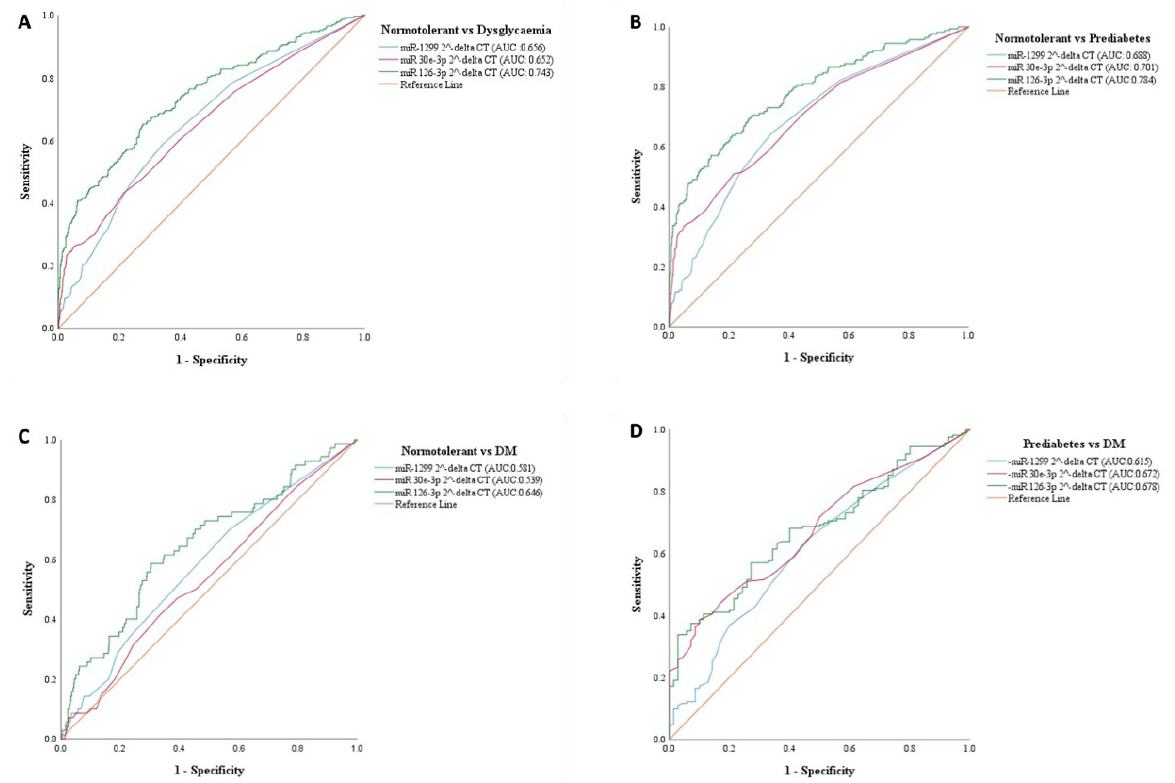
Figure 2. Receiver operating characteristic (ROC). ROCs were constructed for each miRNA to evaluate their diagnostic value for prediabetes, diabetes, dysglycaemia as positive cases and normotolerant people as negative cases, as well as for diabetes as positive cases and prediabetes as negative cases. ( A ): Dysglycaemia vs normotolerant ( B ): Prediabetes vs normotolerant ( C ): T2DM vs normotolerant ( D ): Prediabetes vs T2DM. Table 6. Performance of miR-126-3p and HbA1c in predicting dysglycaemia.